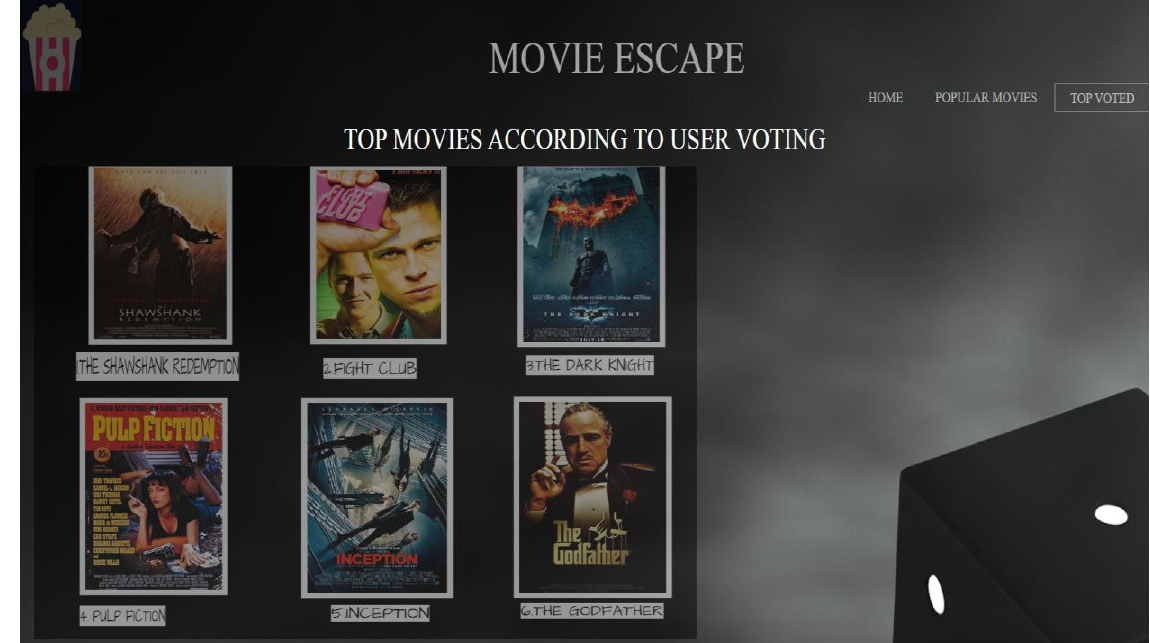
Figure 4. Popular Movies of all time.